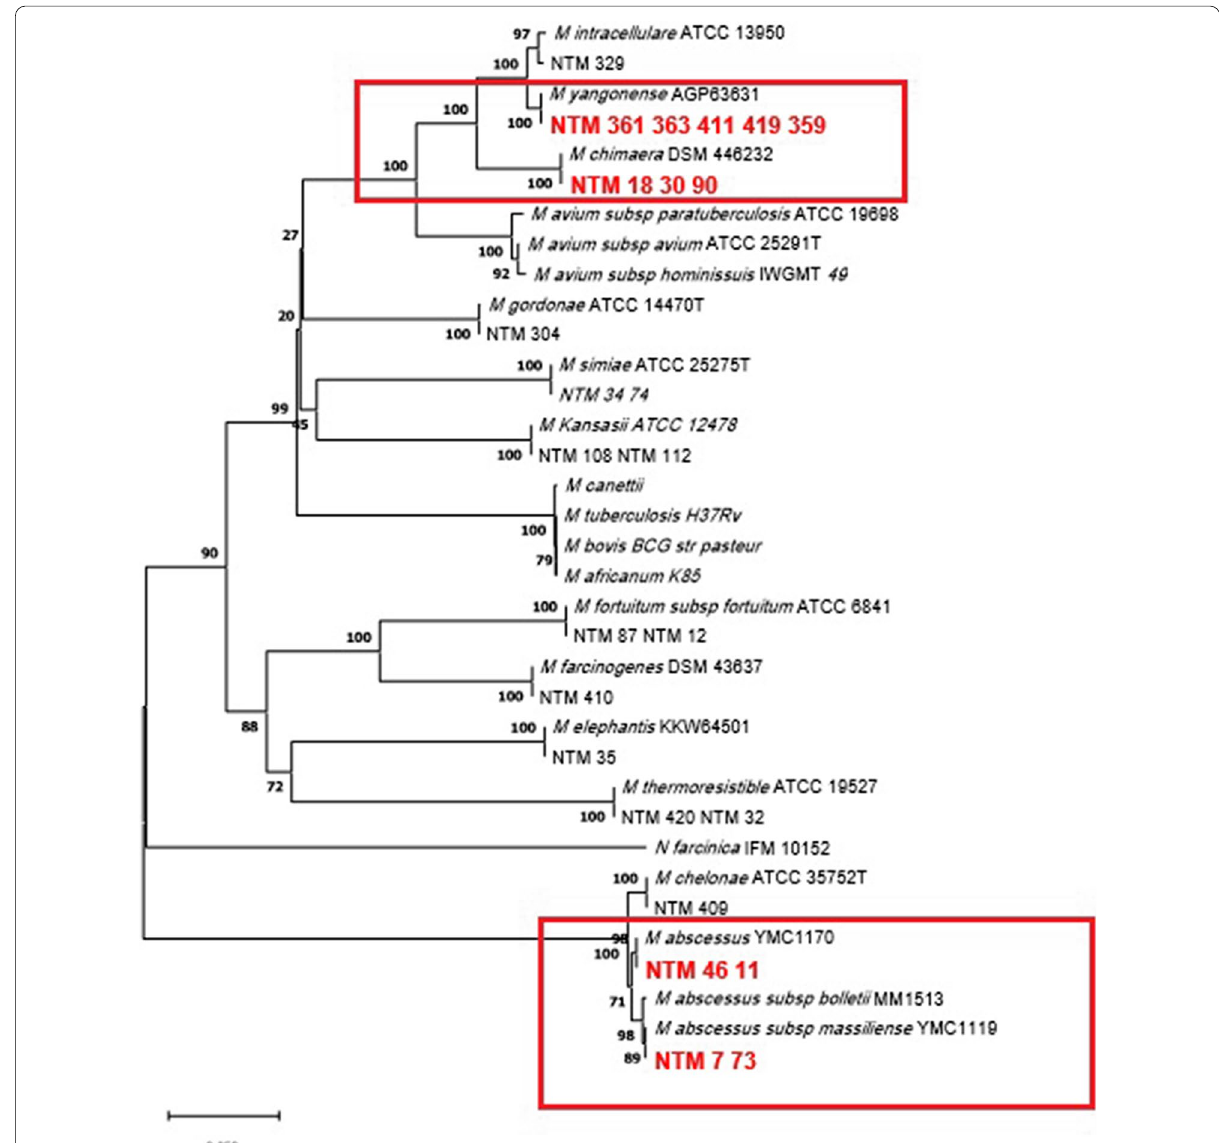
Fig. 3 Phylogenetic relationship (evolutionary tree) of clinical isolates of nontuberculous Mycobactera based on cya gene sequencing (the maximum likelihood tree generated using the Tamura 3-parameter model in MEGA11 software). Boxes are represented of isolates that could be identified by cya